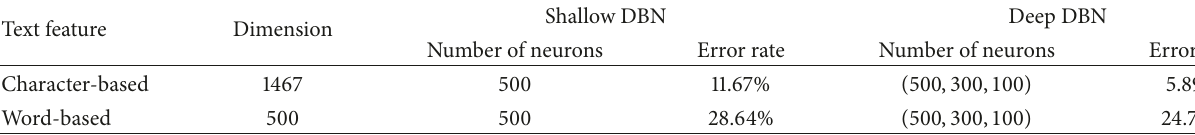
Table 2: Character-based vector and word-based vector results.